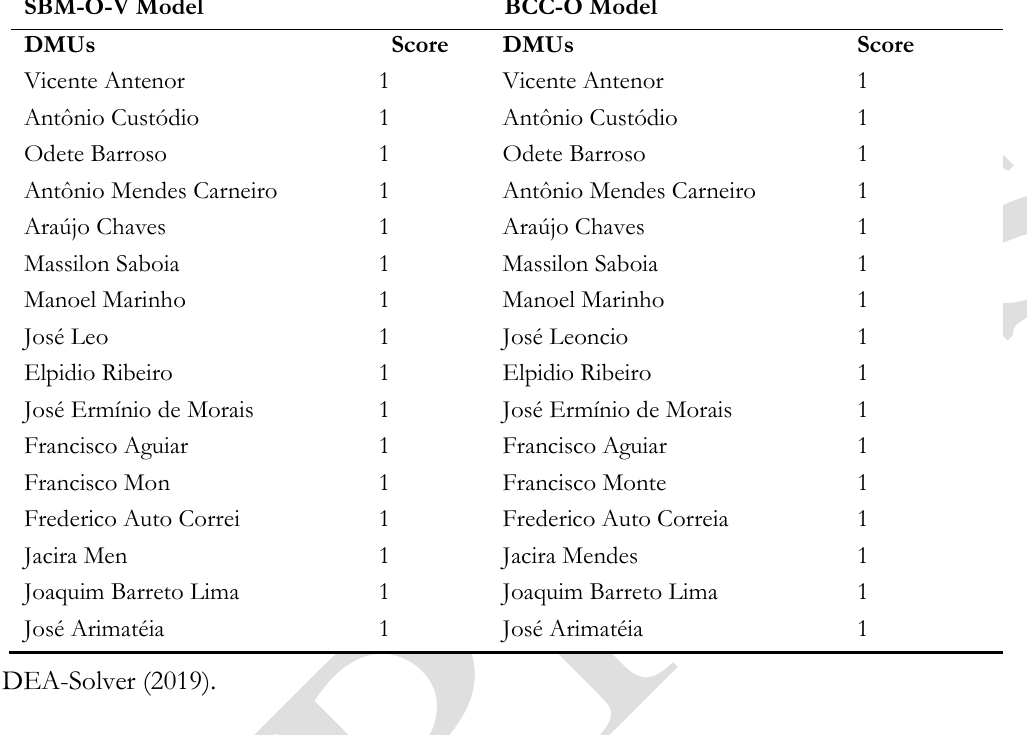
Table 2 - Efficient Production Units, corresponding on SBM Models – O-V and DEA